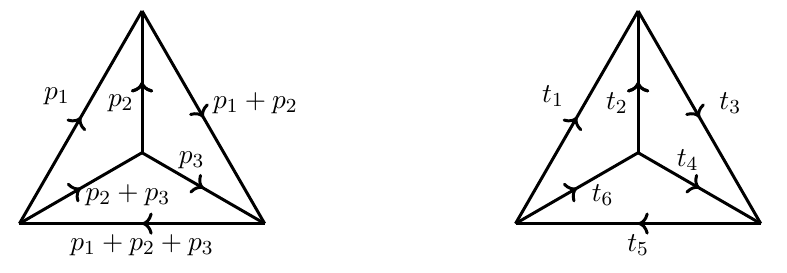
Figure 1 . The tetrahedral graph with labelling of momenta and parameters of the generating